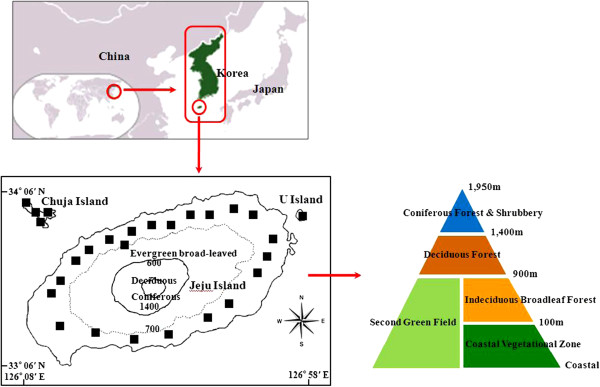
Investigation sites.